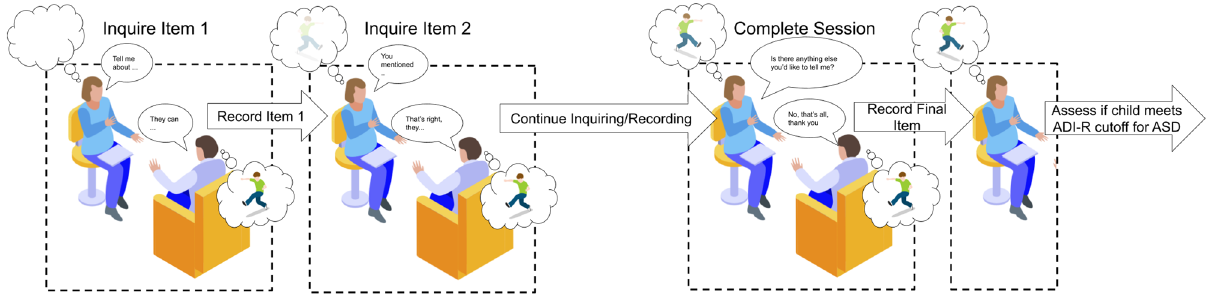
Figure 1. ADI-R administration process. The parent is interviewed by a clinician. The clinicians asks open- ended questions that are tied to an item and listens to the responses from a parent. Typically the clinician is listening and asking about specific examples of the child’s behavior in relation to the item at hand. The clinician records a rating based on the presented information and can leave notes to themselves. After the interview is complete the clinician uses their recorded ratings to complete the ADI-R algorithm computing whether the child meets the instrument’s cut-off thresholds for